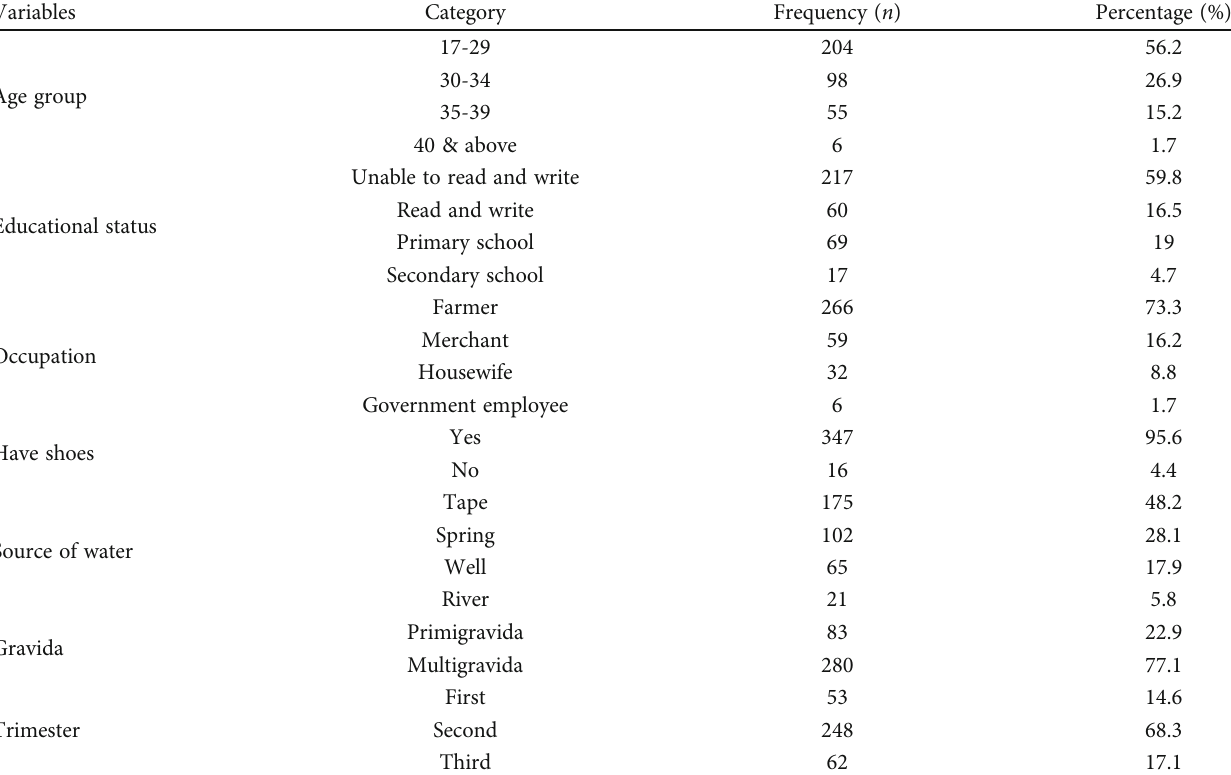
Table 1: Sociodemographic pro fi le of pregnant women at Debre Elias district, March 2021 to July